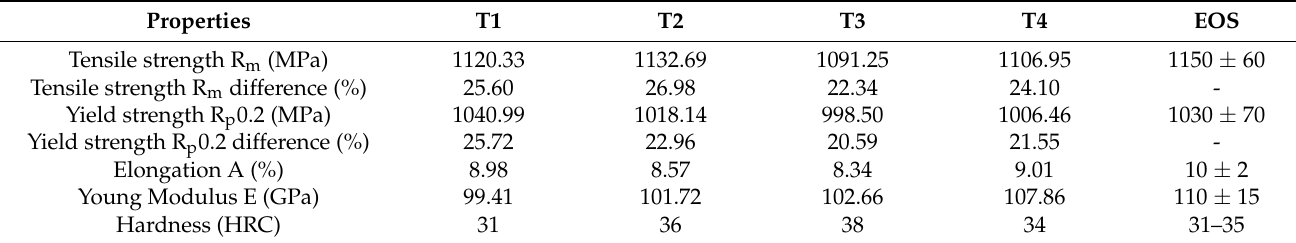
Table 5. Mechanical properties of the DMLS Ti6Al4V